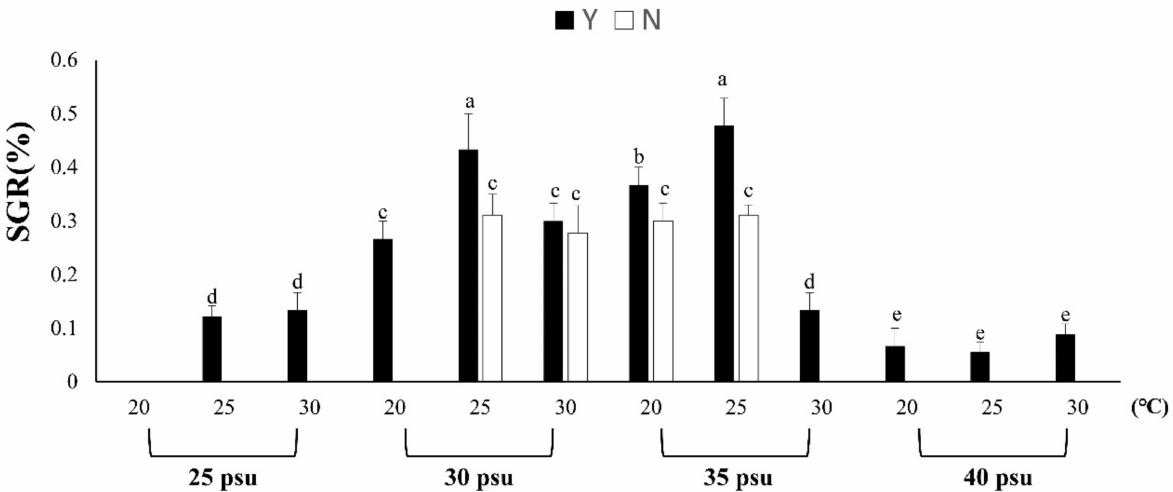
Figure 1. The effect of feeding on Briareum violacea SGR during temperature and salinity stress. Different Latin alphabet letters indicate significant differences among groups ( p < 0.05). The values are expressed as the means ± SDs ( n = 30 colonies). Y: feeding treatment group, N: nonfeeding treatment